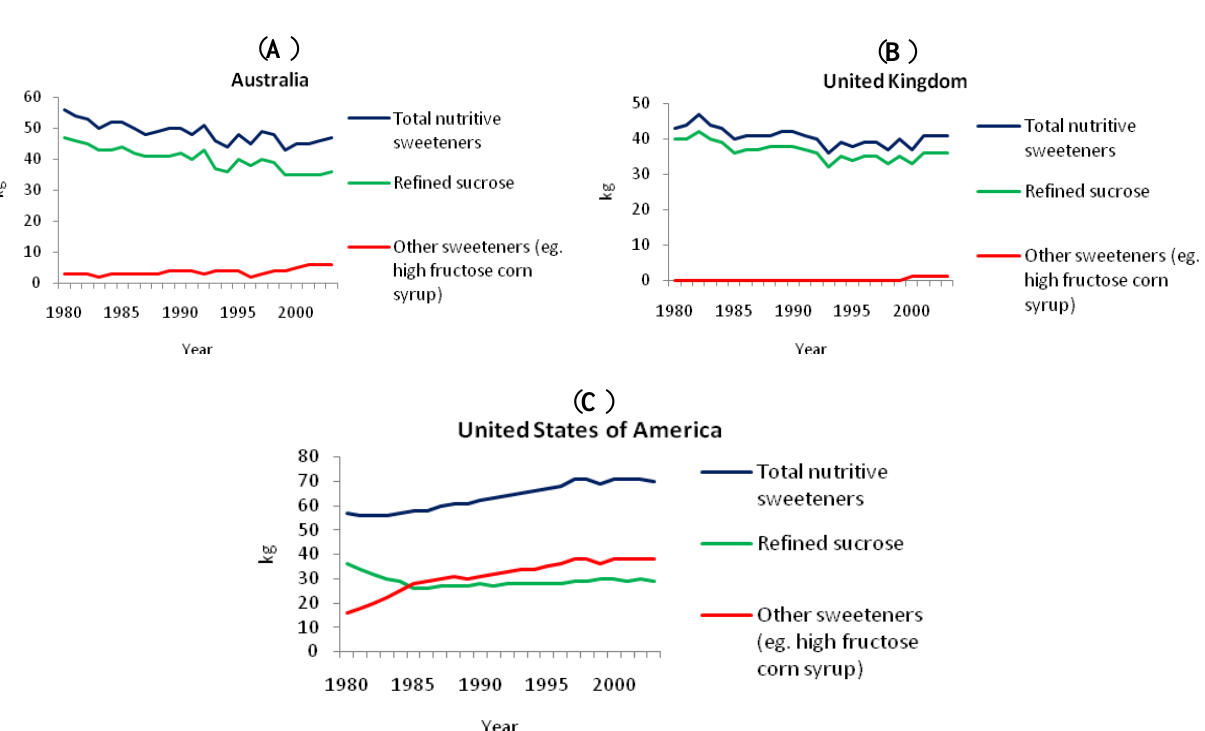
Figure 2. Intake of added sugars (kg/capita/year) in ( A ) Australia, ( B ) the United Kingdom and ( C ) the United States of America